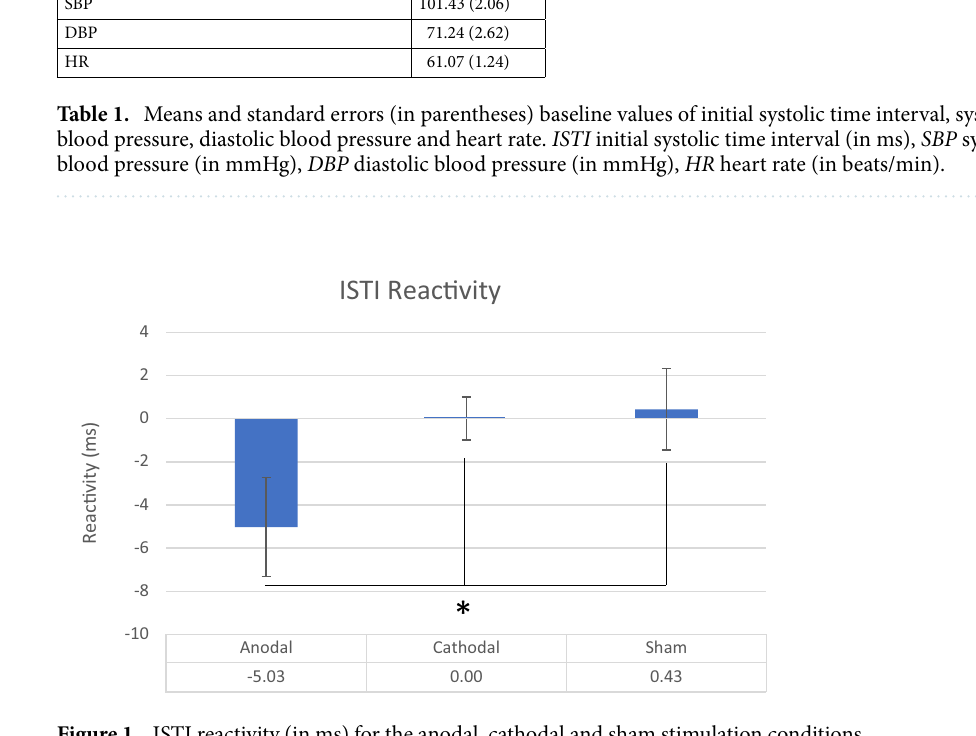
Figure 1. ISTI reactivity (in ms) for the anodal, cathodal and sham stimulation conditions.